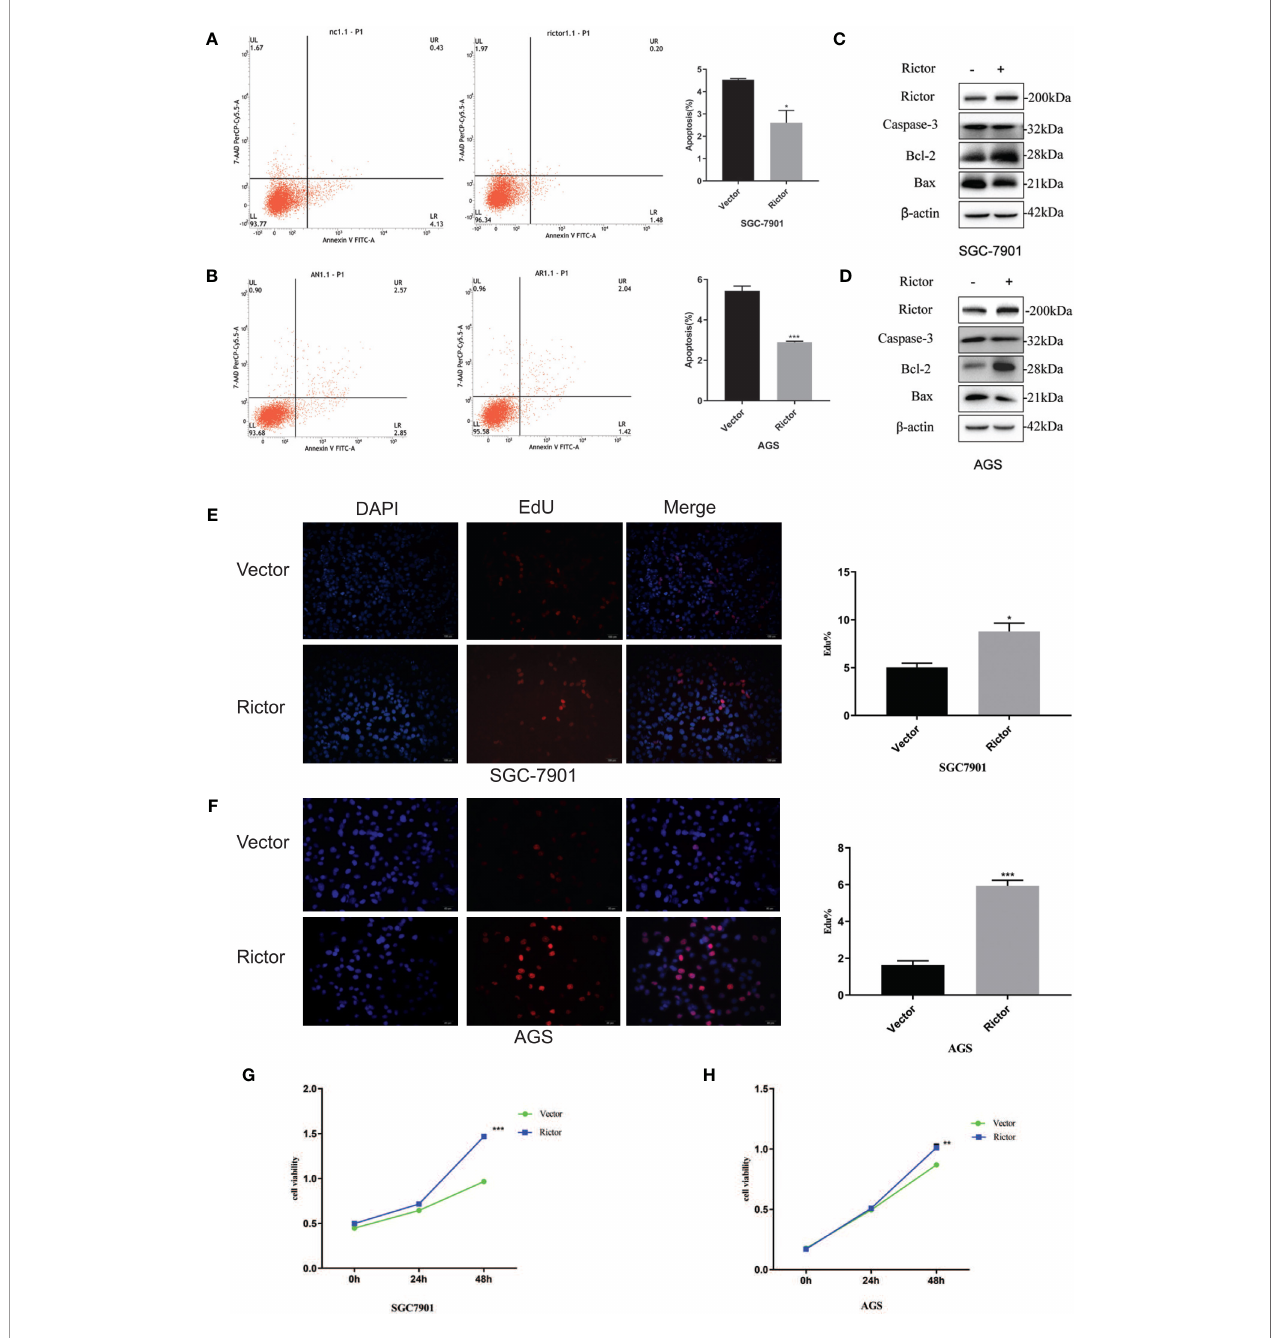
FIGURE 2 | Growth promoting effect of Rictor in gastric cancer cell lines. (A) Transfection of Rictor plasmid can inhibit the apoptosis of SGC-7901 cells (n=9). (B) Transfection of Rictor plasmid can inhibit the apoptosis of AGS cells (n=9). (C) Expression of apoptosis related proteins after transfection with Rictor plasmid in SGC-7901 cells. (D) Expression of apoptosis related proteins after transfection with Rictor plasmid in AGS cells. b -actin served as loading control. (E) EdU veri fi cation that transfection of the Rictor plasmid increased proliferation of SGC-7901 cells (n=3). (F) EdU veri fi cation that transfection of the Rictor plasmid increased proliferation of AGS cells (n=3). (G) Transfection of Rictor plasmid can increase the proliferation of SGC-7901 cells (n=3). (H) Transfection of Rictor plasmid can increase the proliferation of AGS cells (n=3). Values represent the Means ± SD. *P < 0.05, **P < 0.01 and ***P < 0.001 as calculated using the Student ’ s